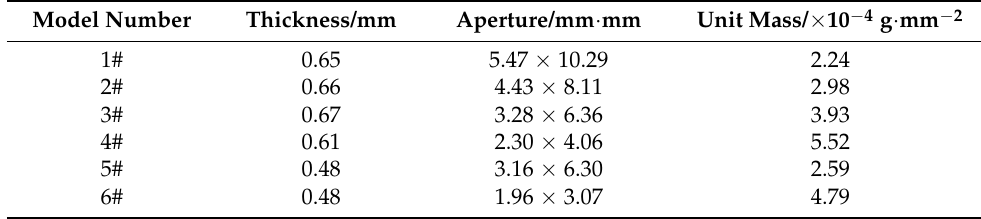
Table 3. Copper mesh